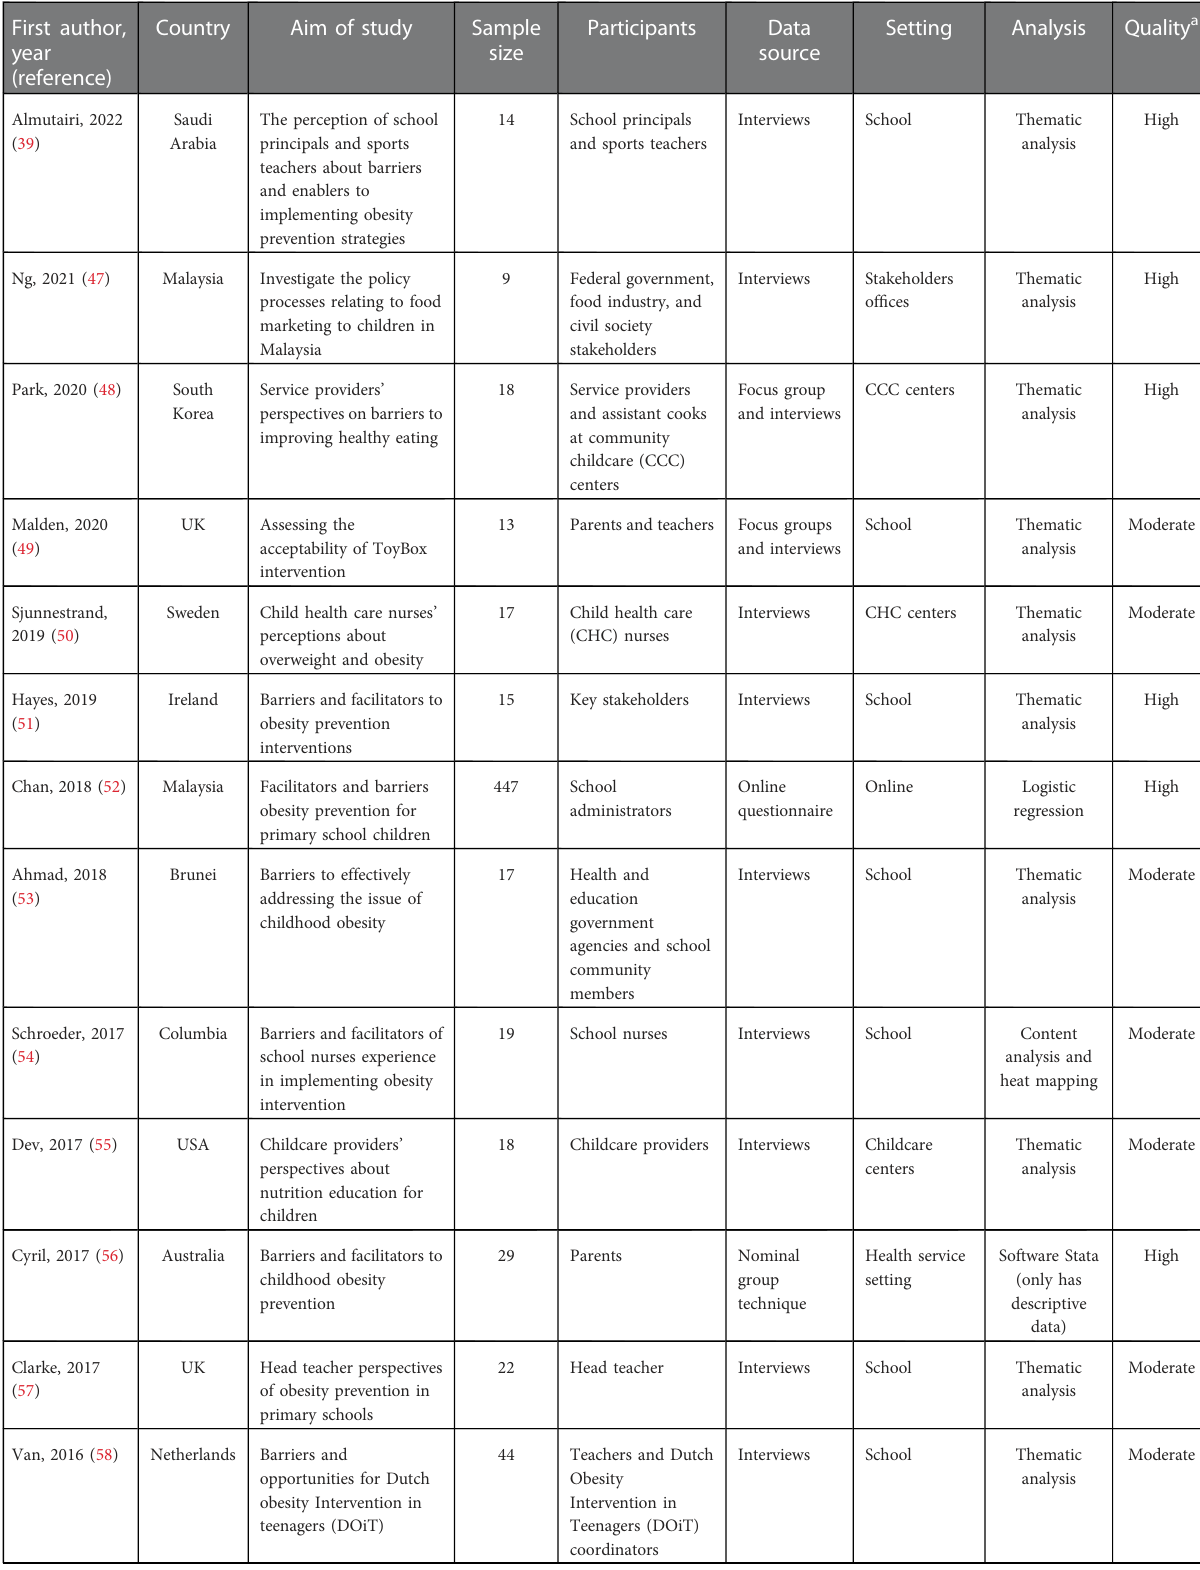
TABLE 1 Characteristics of included